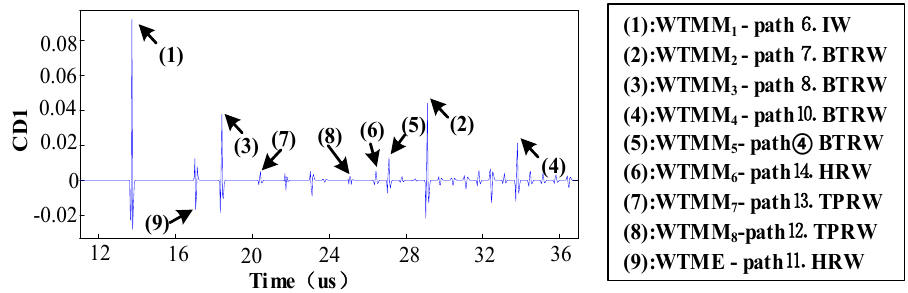
Figure 2. Wavelet-transform modulus-maxima (WTMM) of the aerial-mode traveling wave (TW). If a TW propagates through the full path of a branch (several branches) and reflects at its terminal (their terminals), the distance di ff erence related to this BTRW and the IW is equal to twice the length di ff erence indicates the fault distance measured from the faulted branch terminal. Using observable BTRWs, TW propagation paths could emerge by means of path match to the given network